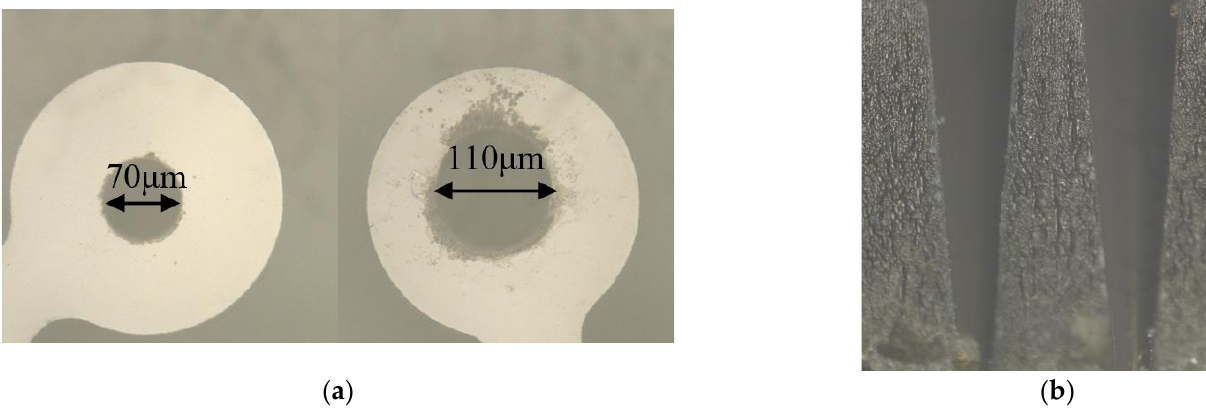
Figure 9. Sketch of the actual punching: ( a ) The diameters are 60 μm and 100 μm; ( b ) Sectional view of holes. of